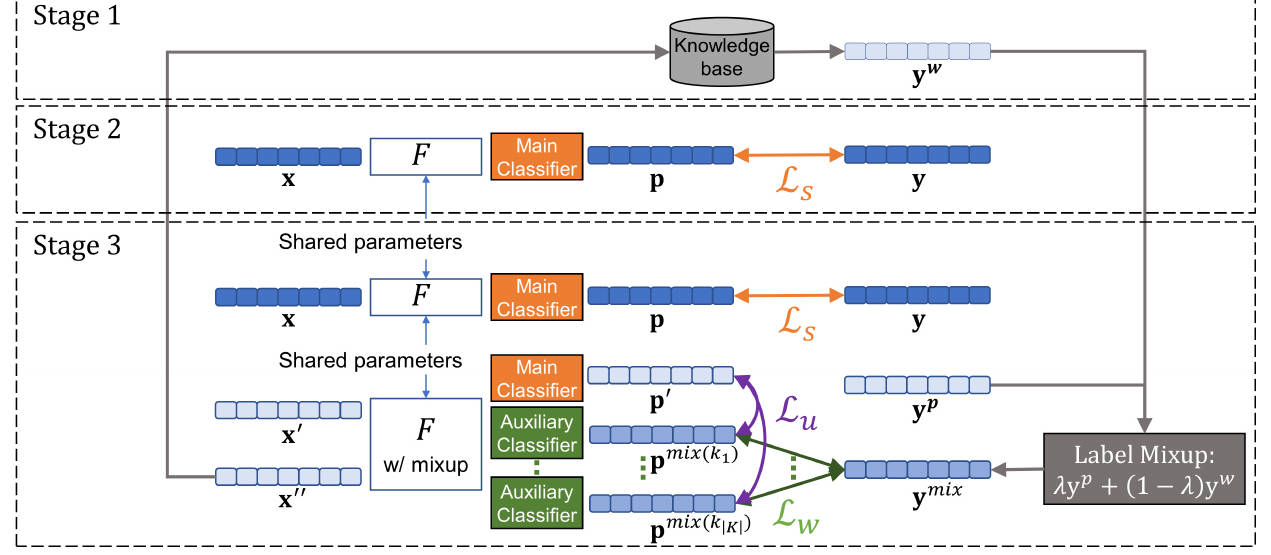
Figure 4. Framework